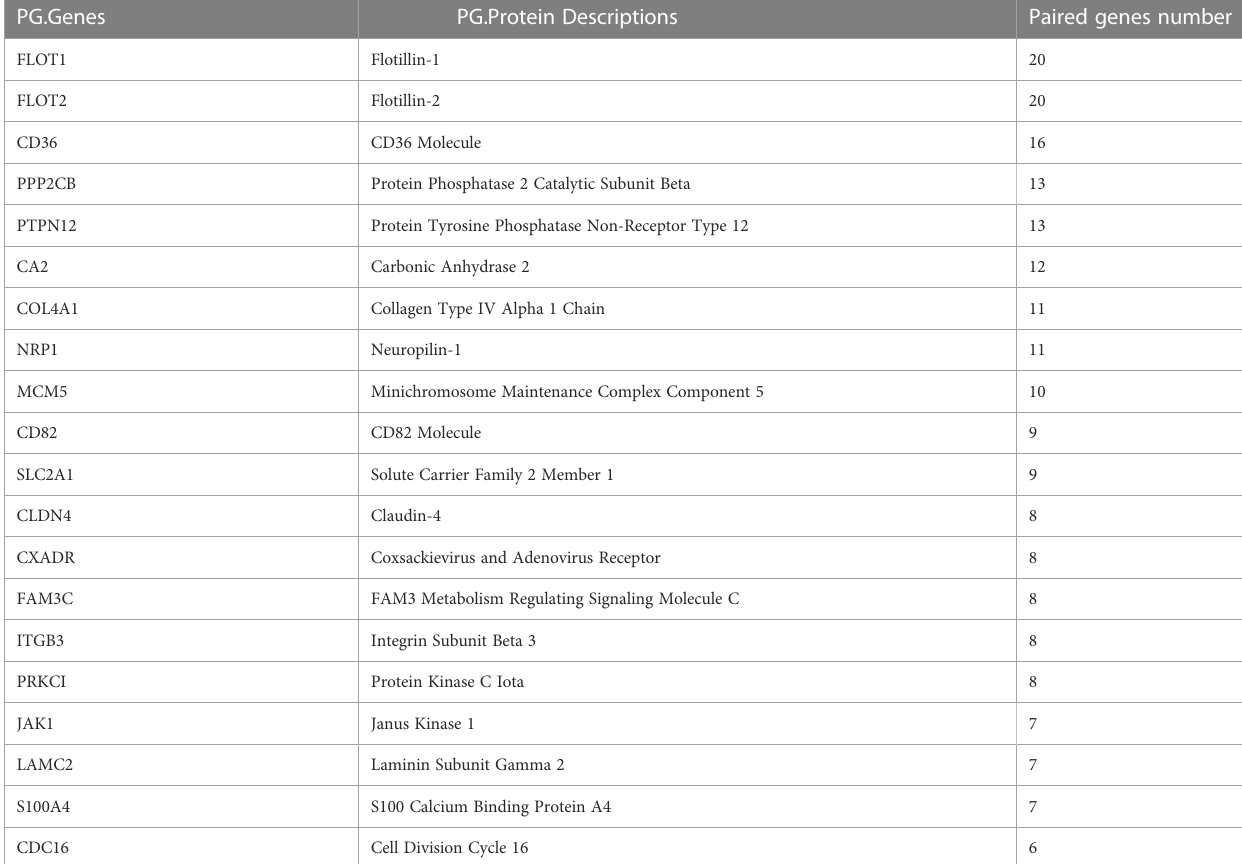
TABLE 2 Top 20 core EMT-related DEPs based on the number of paired proteins. PG.Genes